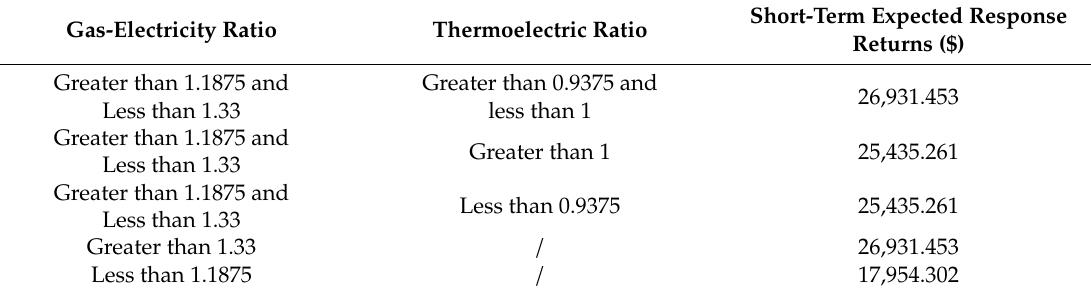
Table 4. Short-term expected response income.